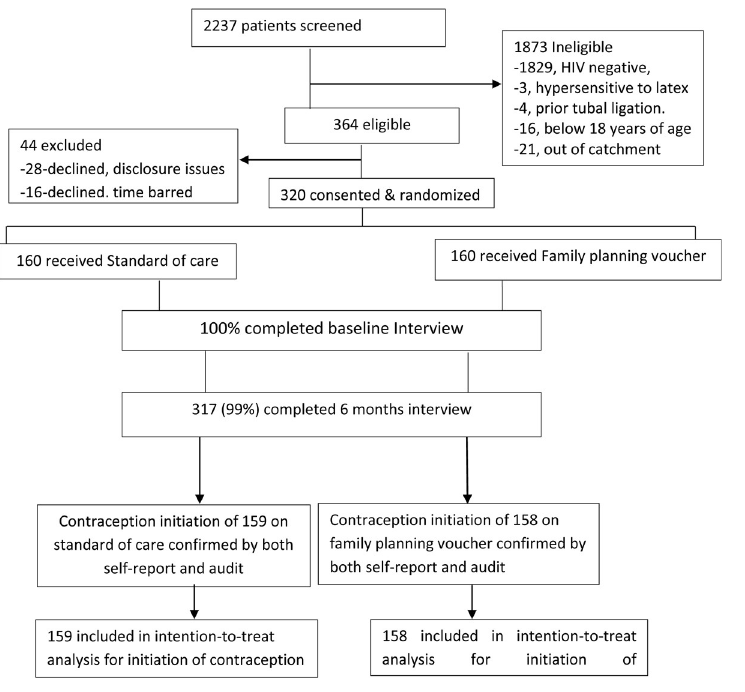
Fig 2. The trial